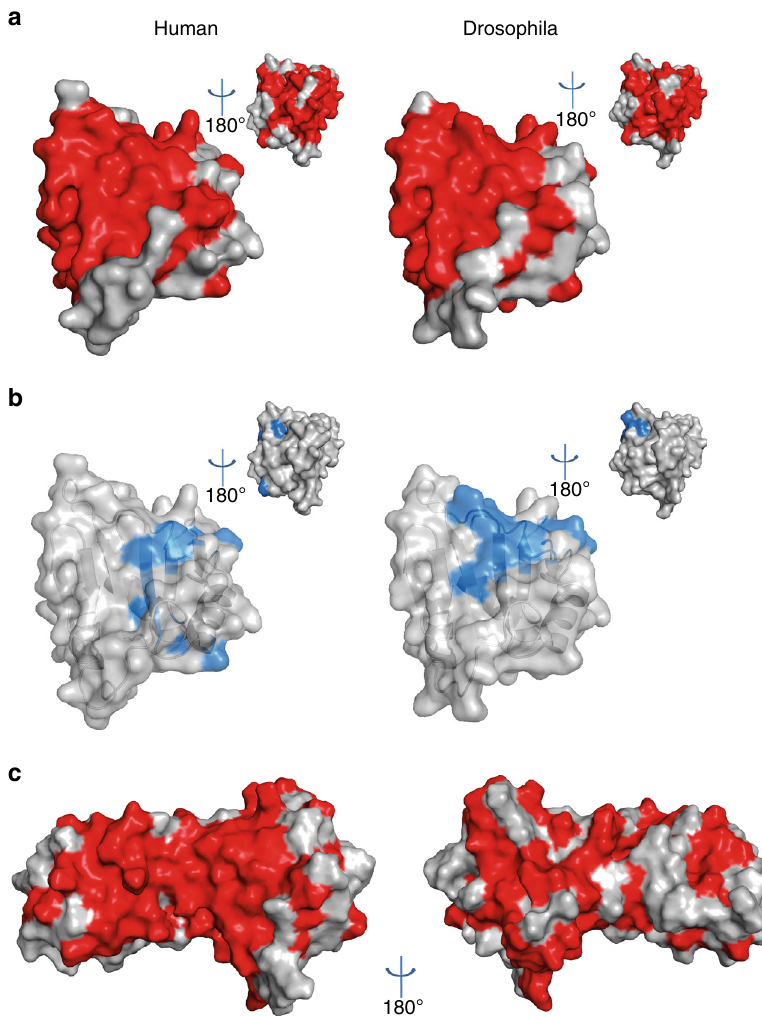
Fig. 6 Syncrip extended RRM1 domain binds RNA using the canonical RRM β -sheet surface. a Residues conserved (identical) in human and Drosophila are coloured in red on the Drosophila structure (this study) and a derived human protein structural model (Swiss-model) of the extended RRM1 domain. The smaller images show 180° rotations of the structures. b Chemical shift changes upon binding of quasi-randomised RNA oligos (see materials and methods) are mapped in blue on the surface of extended RRM1 domain in human and Drosophila. The small images show 180° rotations of the structures. c The interaction of the NURR and extended RRM1 domains aligns the conserved (RNA binding) surfaces of the two domains. Conserved residues are coloured in red on the structure of the two-domain, NeR1